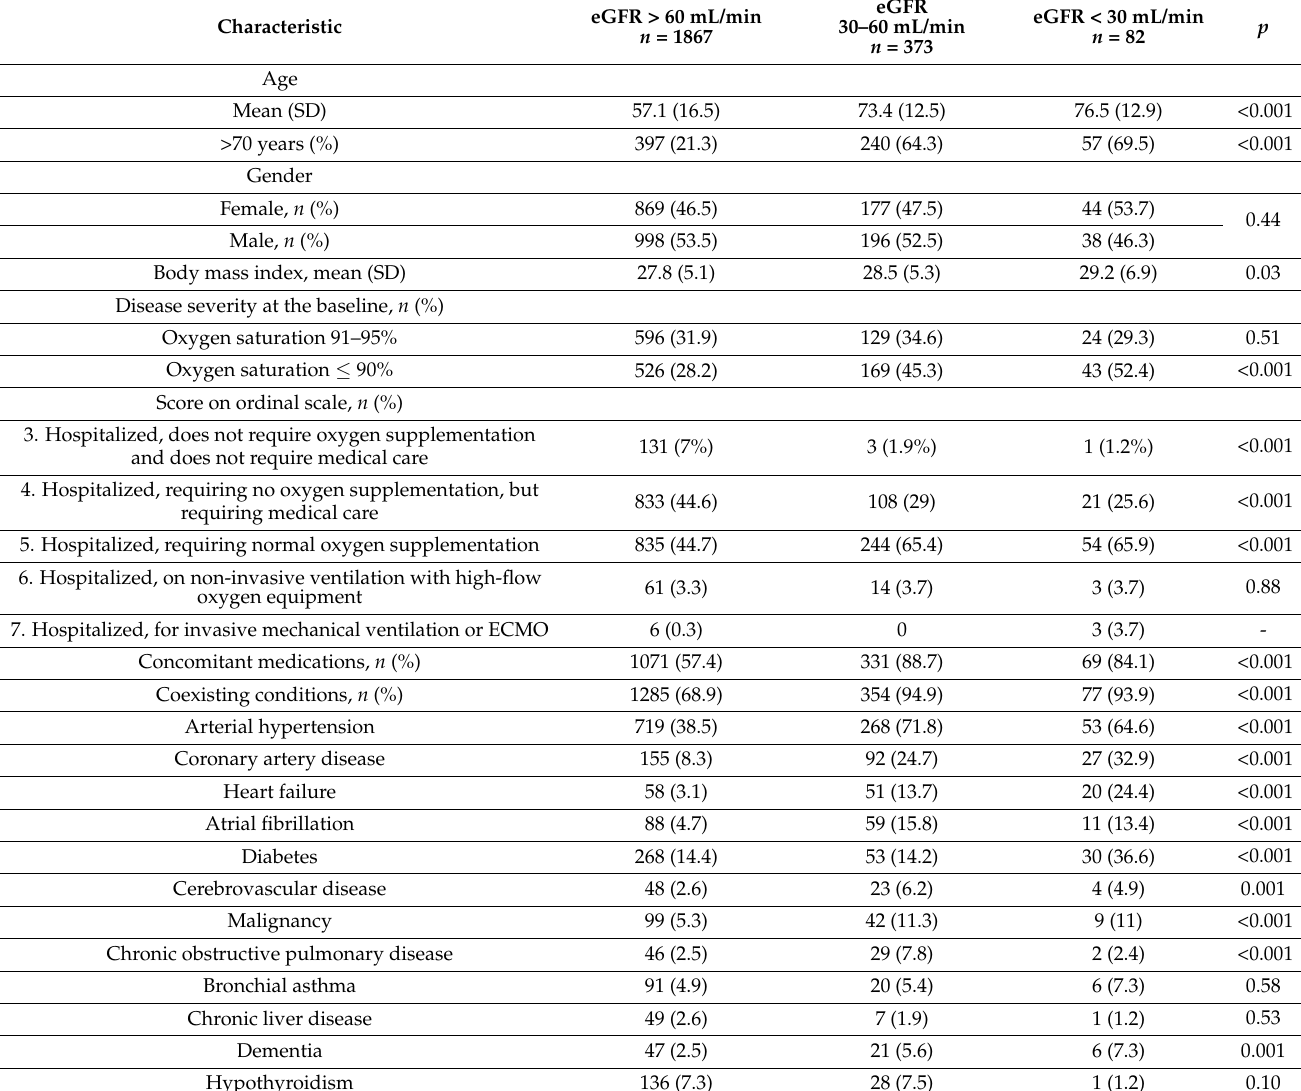
Table 1. Baseline characteristics of patients according to kidney